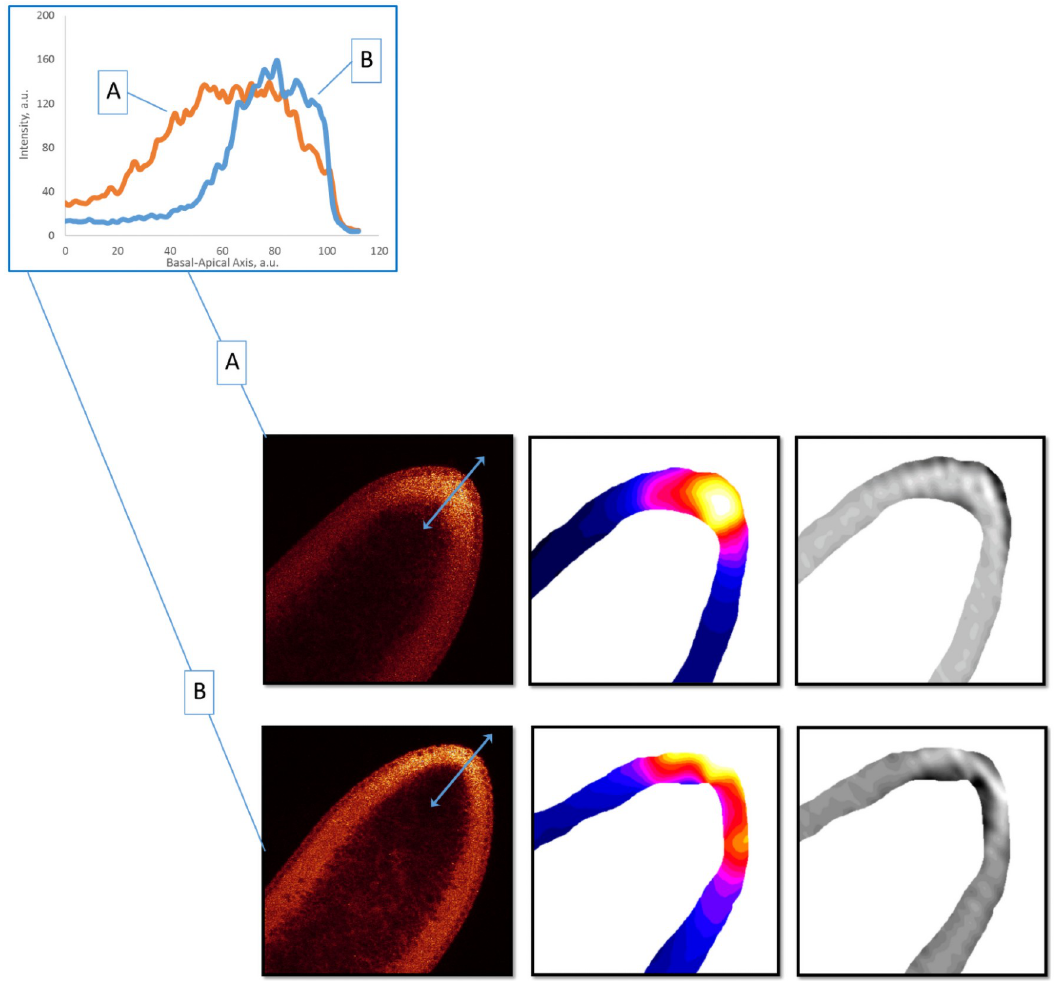
Fig 12. Stau distributions in cortical cytoplasm in cc 13. Raw images (1 st column). 2D SSA decomposition highlights these differences in signal (2 nd column); the 3 rd column shows the residual noise in the SSA decomposition. Inset: corresponding 1D profile changes in the basal-apical direction (two-headed arrows on A and